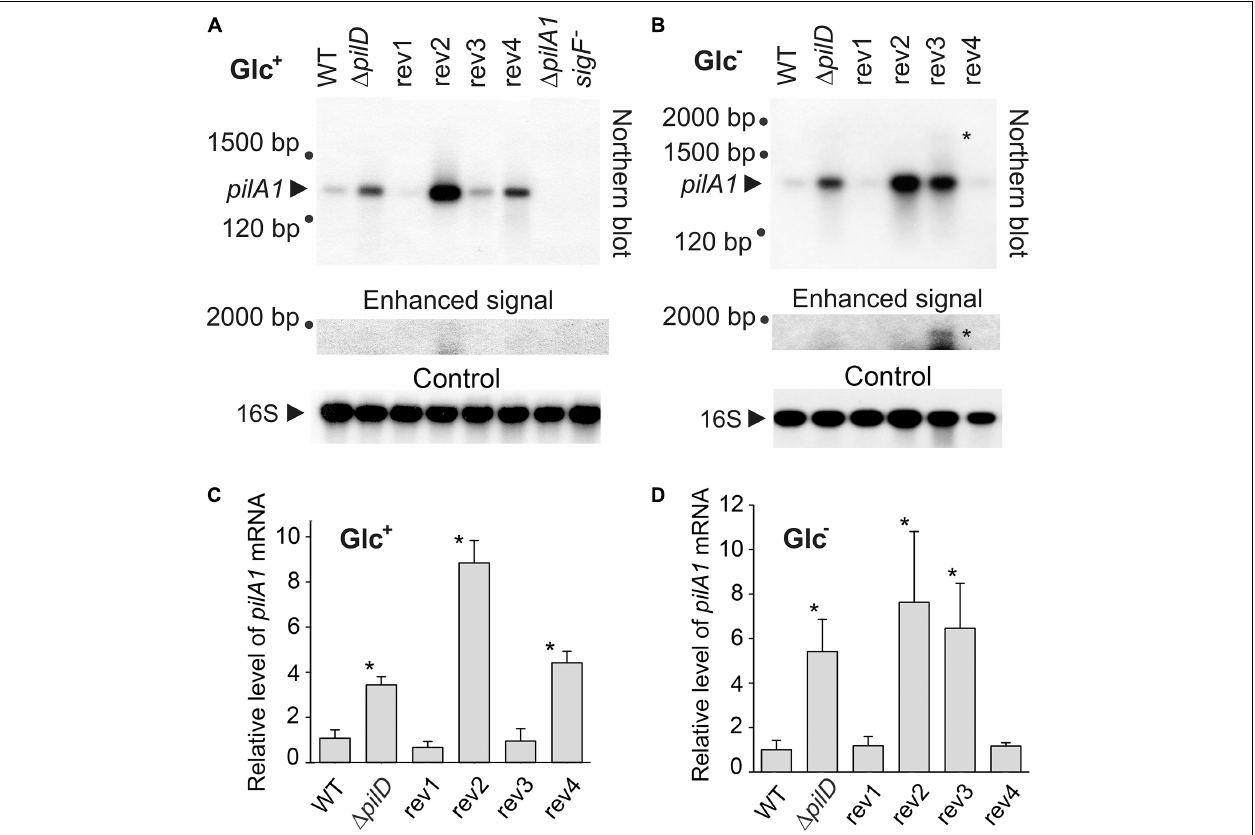
FIGURE 4 | Cellular levels of pilA1 mRNA in WT, (cid:49) pilD mutant, and (cid:49) pilD revertant strains. RNA was isolated from WT and mutant cells that were grown for 2 days in the presence (A) or absence (B) of glucose. RNA was blotted and hybridized sequentially with radiolabeled probes against pilA1 mRNA and 16S rRNA. An unknown large transcript, detected with the pilA1 probe, is indicated by an asterisk. As the signal of this long transcript is much weaker than the signal of pilA1 , an enhanced image of the upper part of the membrane is also shown. (cid:49) pilA1 / 2 and sigF − mutants were included as negative controls; 3.75 µ g of total isolated RNA was loaded in each lane. (C,D) Hybridization was repeated using independent cell cultures, the density of the signals were quantified using ImageQuant TL 10 (GE Healthcare), normalized to the signal of 16S RNA and plotted. The values represent means ± SD from three independent measurements. Asterisks indicate statistically significant differences in the pilA1 mRNA levels between WT and other strains as tested using a paired Student’s t -test (* P <